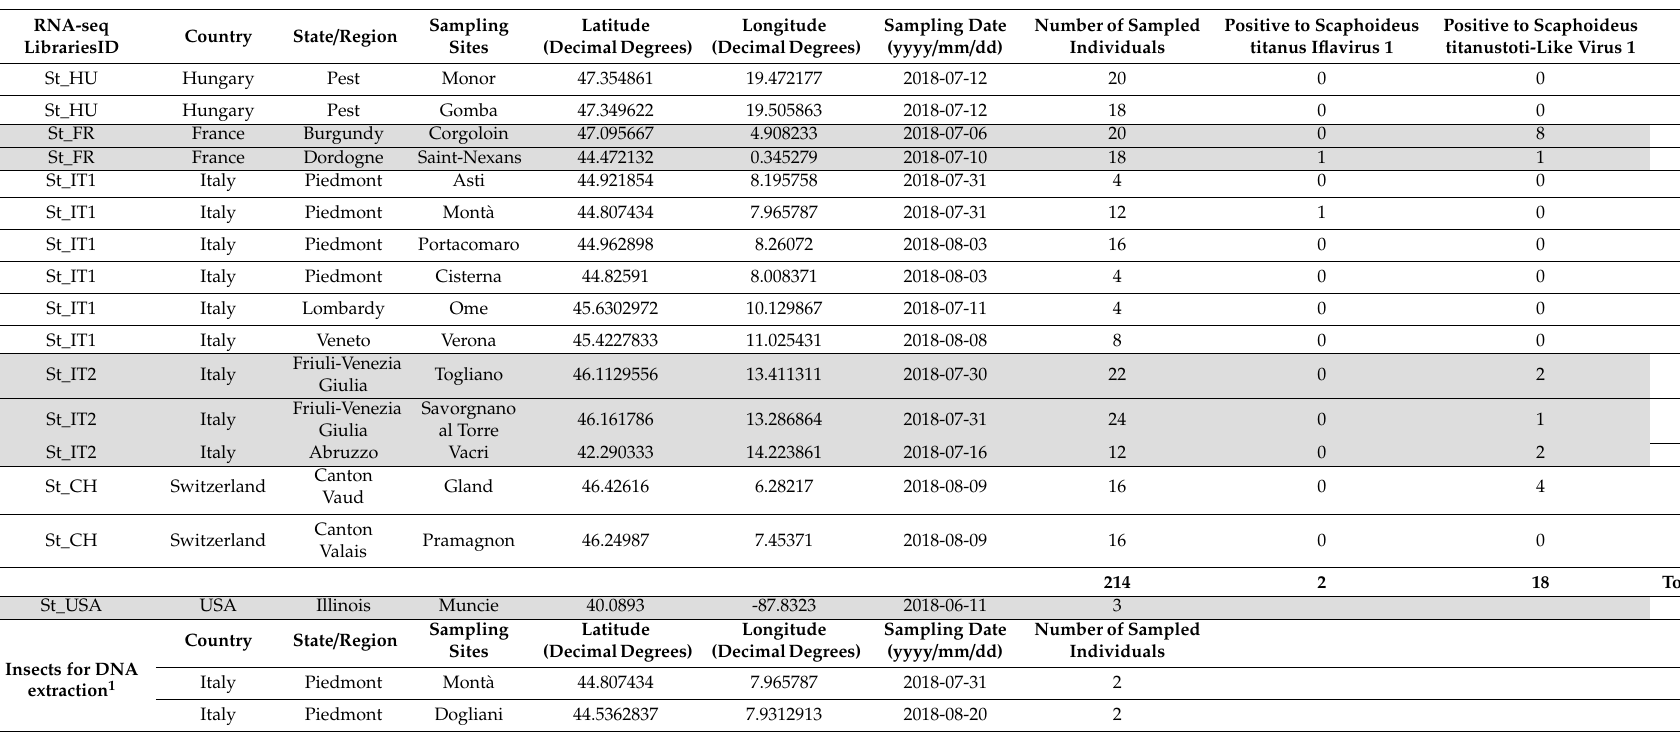
Table 1. Sampling information, RNA-seq pooling strategies and prevalence of Scaphoideus titanus iflavirus 1 and Scaphoideus titanus toti-like virus 1 in the European S. titanus